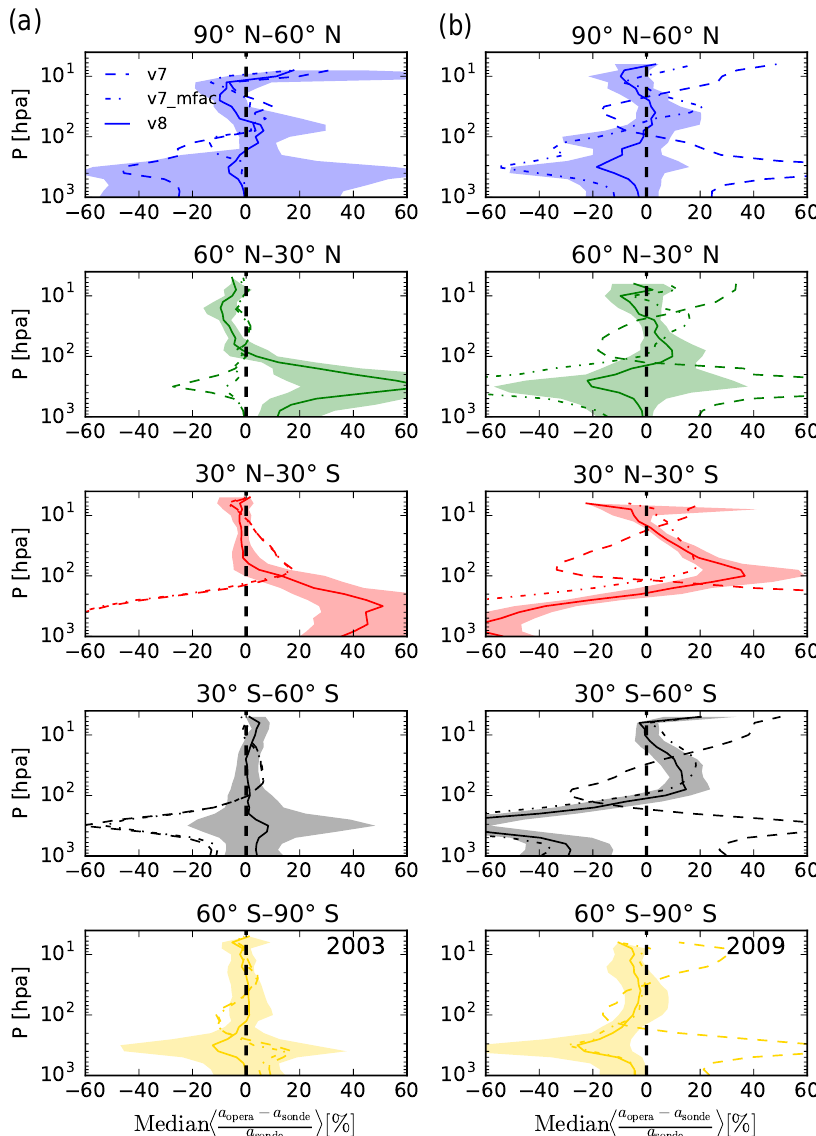
Figure 7. Relative difference between ozone profiles retrieved from three different SCIAMACHY L1 data versions and convolved ozone sonde profiles. The three L1 versions are indicated as a dashed line (v7), dash-dotted line (v7 mfac ) and solid line (v8). The shown quantity is the relative difference in ozone column per layer: (OPERA – sonde) / sonde. Results are shown in five rows for five latitude bands as indicated. Panel (a) shows results for the year 2003 and panel (b) for the year 2009. The uncertainty band (25–75 percentile difference) in the shaded area is shown for the v8 data